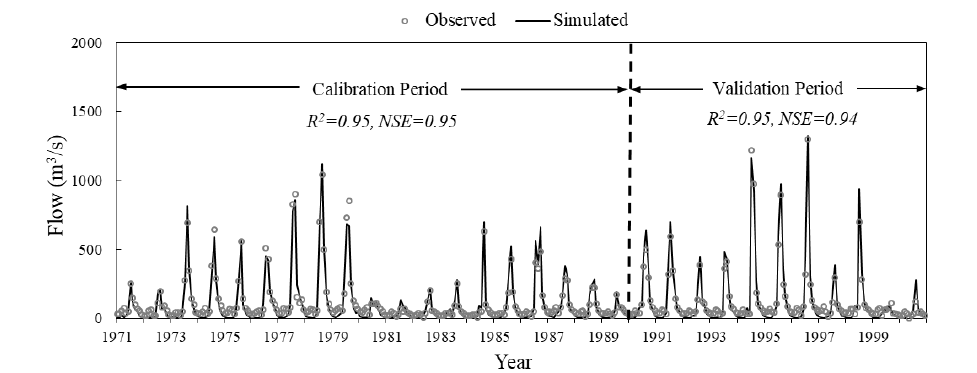
Figure 3. The hydrological calibration and validation results of the Luanxian Station.